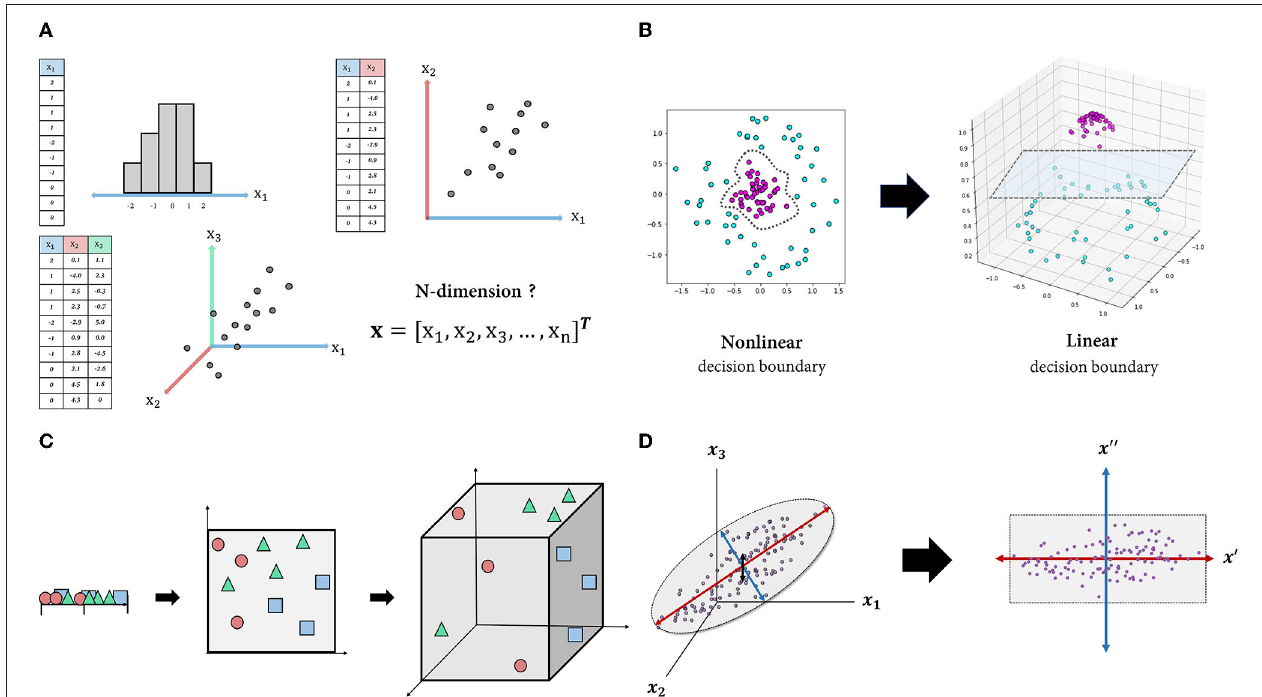
FIGURE 1 | Schematic figures explaining the features of high-dimensional data. (A) : Intuitive understanding of multidimensional data. Each observation (row) in each table is described by one or more features (columns) and visualized as a point in one-, two- or three-dimensional space. This representation is easily extended to four-dimensional space or higher, but it cannot be visualized. (B) : By transforming the dataset into high-dimensional space, the data can be separated using a linear decision boundary. (C) : Curse of dimensionality. As the dimension of the space increases, the volume of the space expands exponentially, and the density of the space becomes increasingly sparse. (D) : Projection into an intrinsic-dimensional space. Data laid out in three-dimensional space can be approximated by a two-dimensional plane composed of newly discovered axes that account for majority of the data